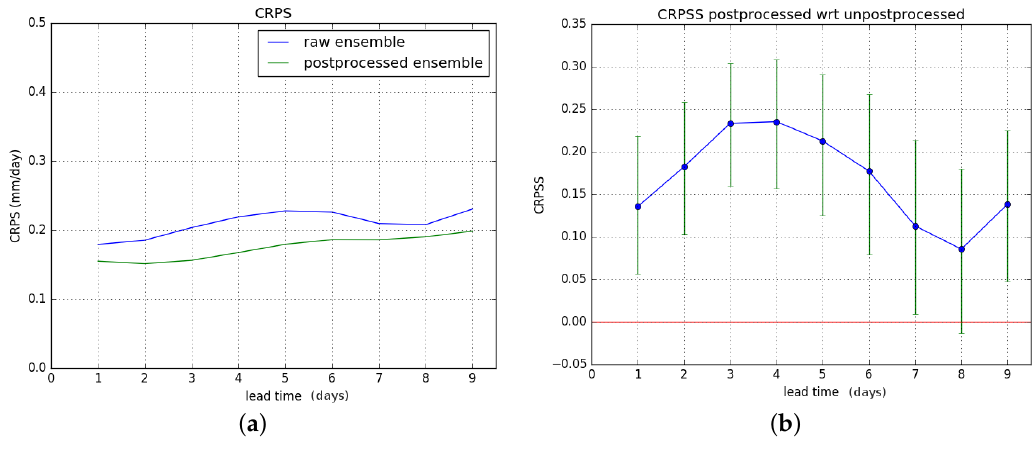
Figure 12. CRPS and CRPSS improvement for hydrological summer. ( a ) CRPS comparison; ( b ) Improvement due to